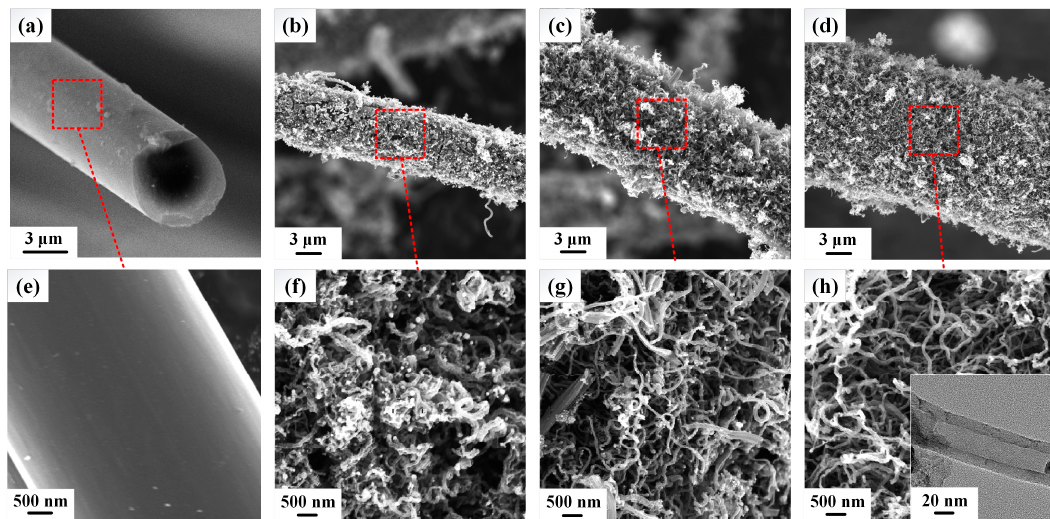
Figure 3. SEM images of the pristine CF and CNTs/CF samples with different lengths of CNTs at different growth times. ( a ) Pristine CF; ( b ) CNTs/CF-T5 (5 min of CNT growth); ( c ) CNTs/CF-T10 (10 min of CNT growth); ( d ) CNTs/CF-T15 (15 min of CNT growth). ( e – h ) Magnified images of the surfaces of ( a – d ), respectively. The inset in ( h ) shows the TEM image of a CNT grown on the surface of a CF by the CVD method.